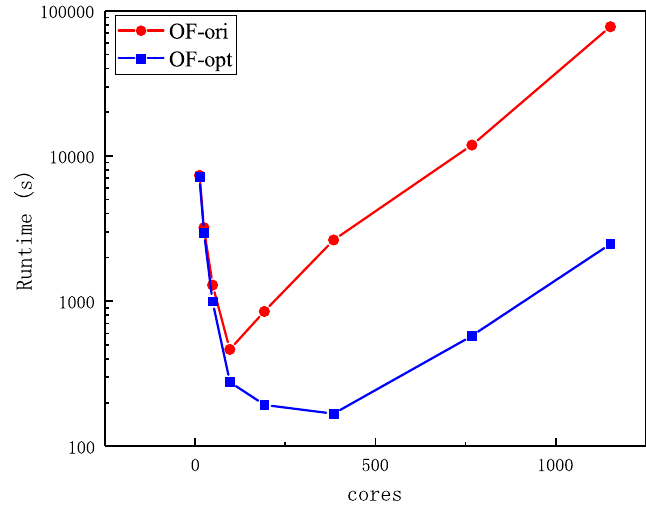
Figure 15. Strong scaling run time in